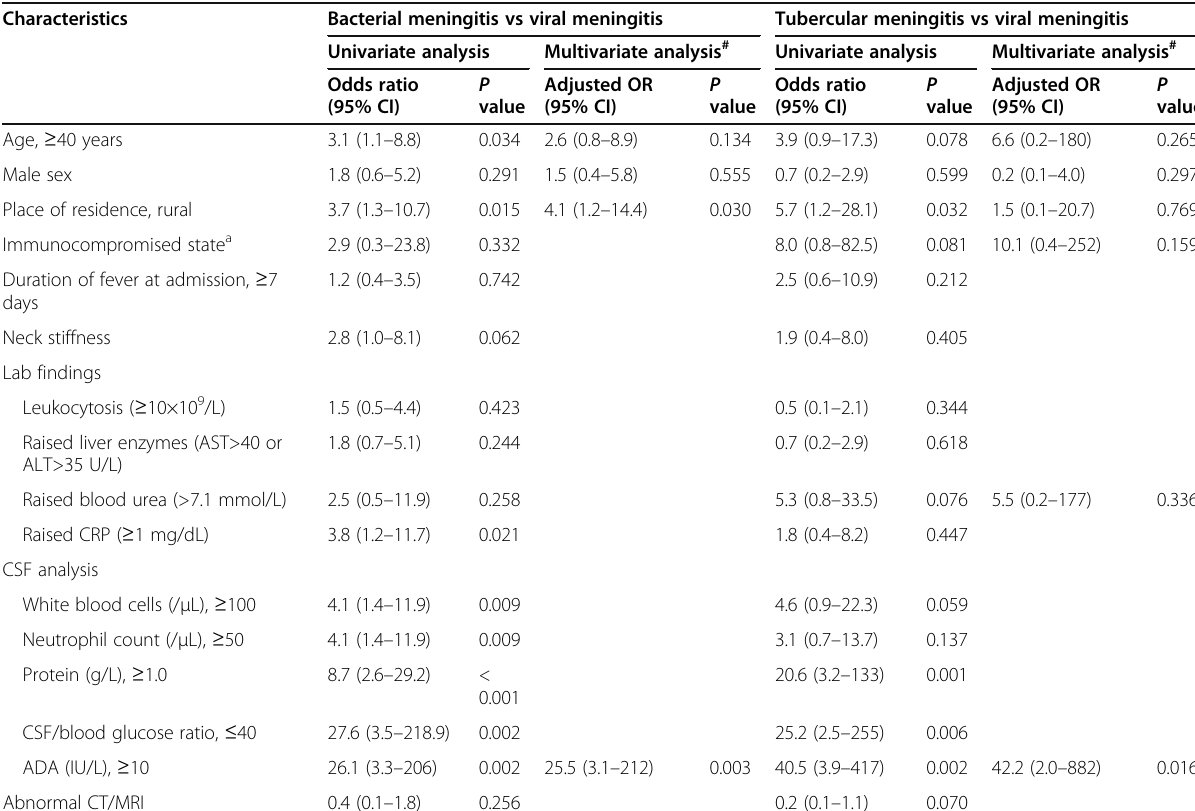
Table 4 Analysis of associated risk factors by meningitis type